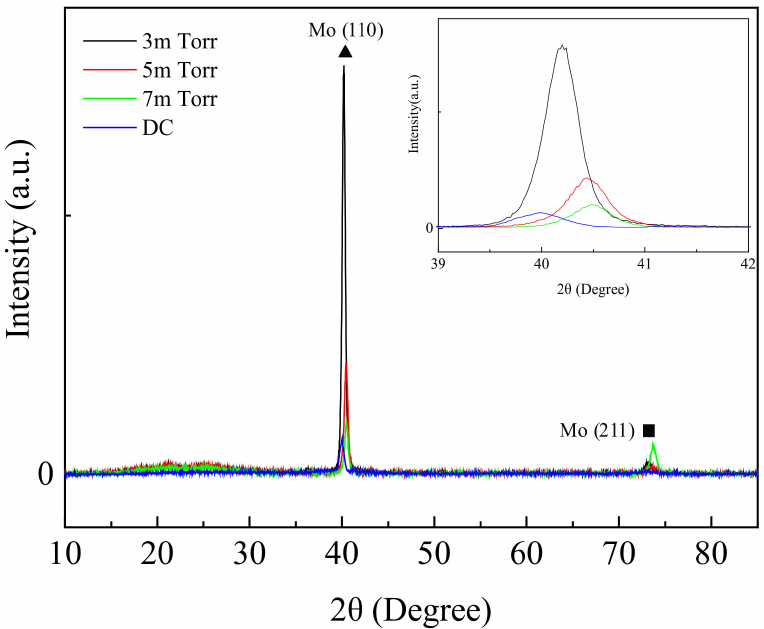
Figure 5. XRD analysis of conventional DC sputtering and HiPIMS with different working pressures of Mo